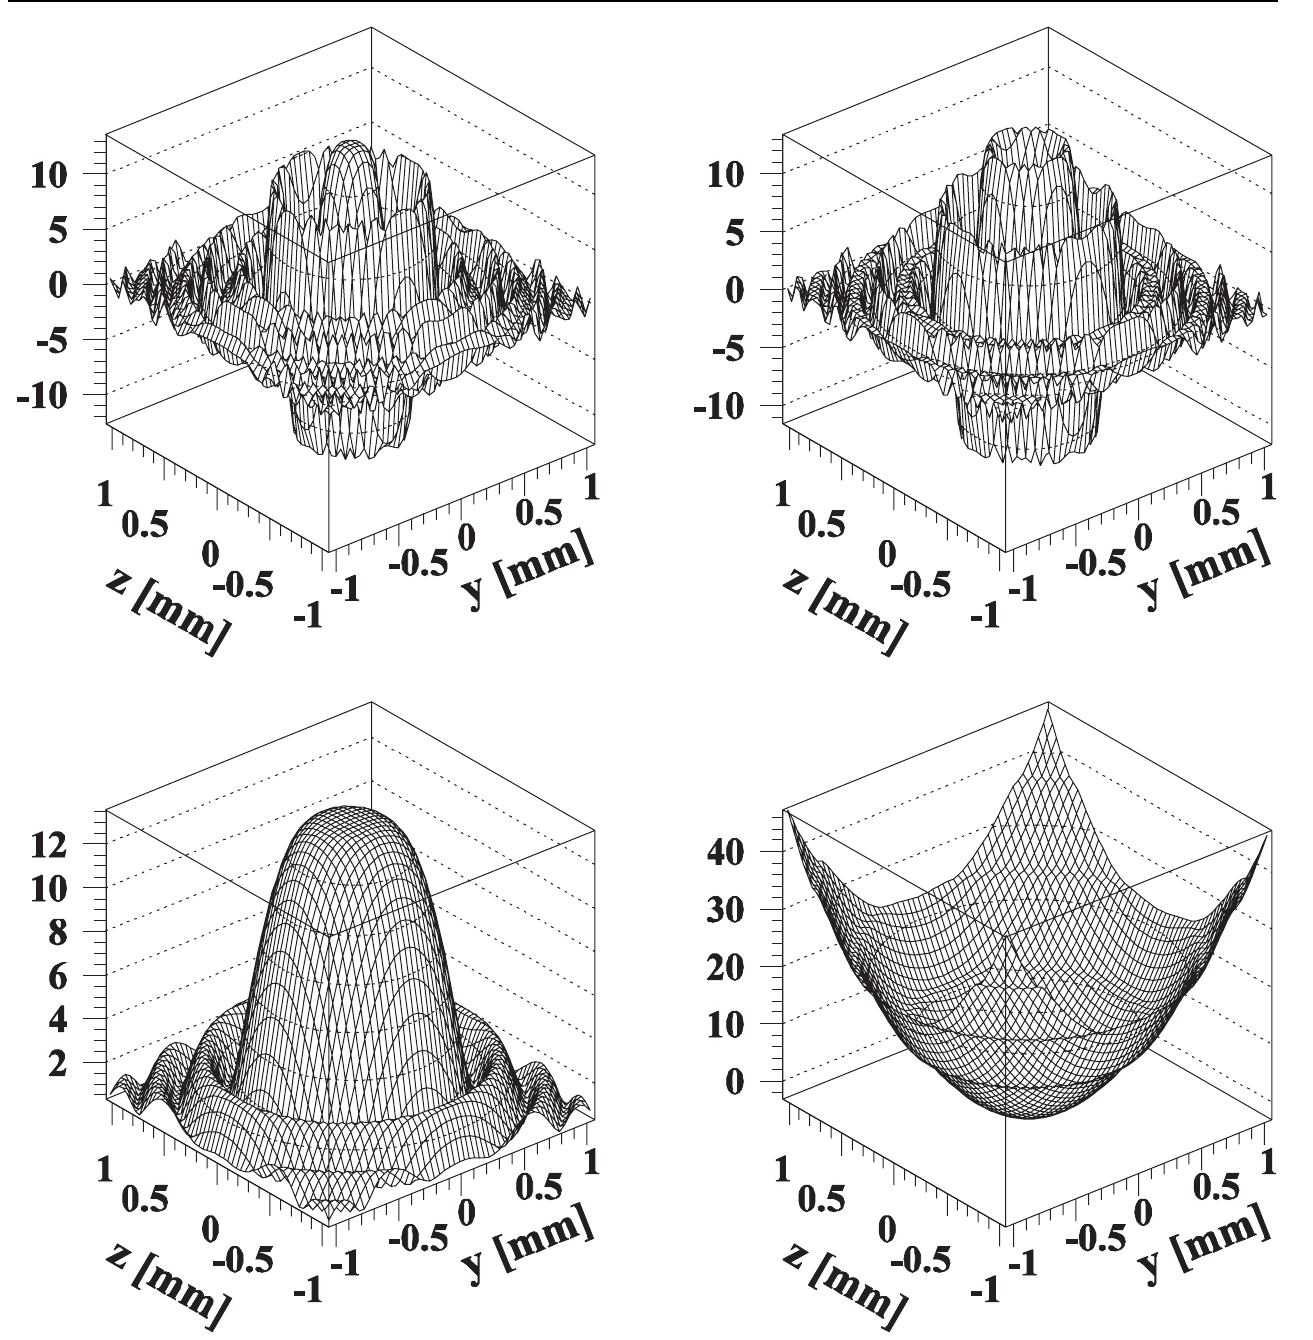
FIG. 9. Electric field distribution of a spontaneous undulator source (top) and an equivalent amplitude and phase representation of the same source